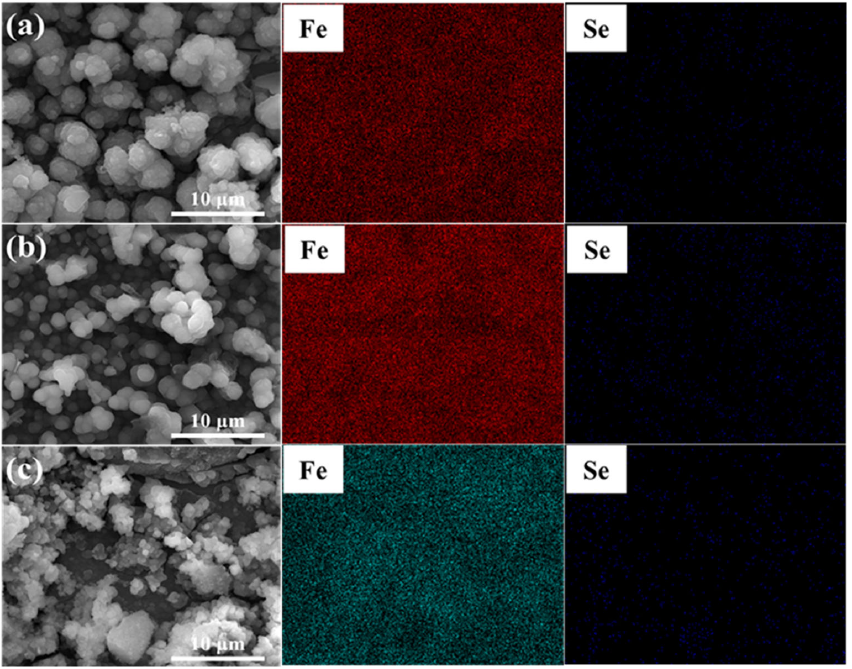
Figure 12. The EDS analysis of 304 stainless ‐ steel samples after being treated by polarization measurements in different solutions and a 4 week immersion test in SG + Na 2 SeO 4 solution: ( a ) SG + CaCl 2 solution; ( b ) SG + Na 2 CO 3 solution; ( c ) SG + Na 2 SiO 3 solution.